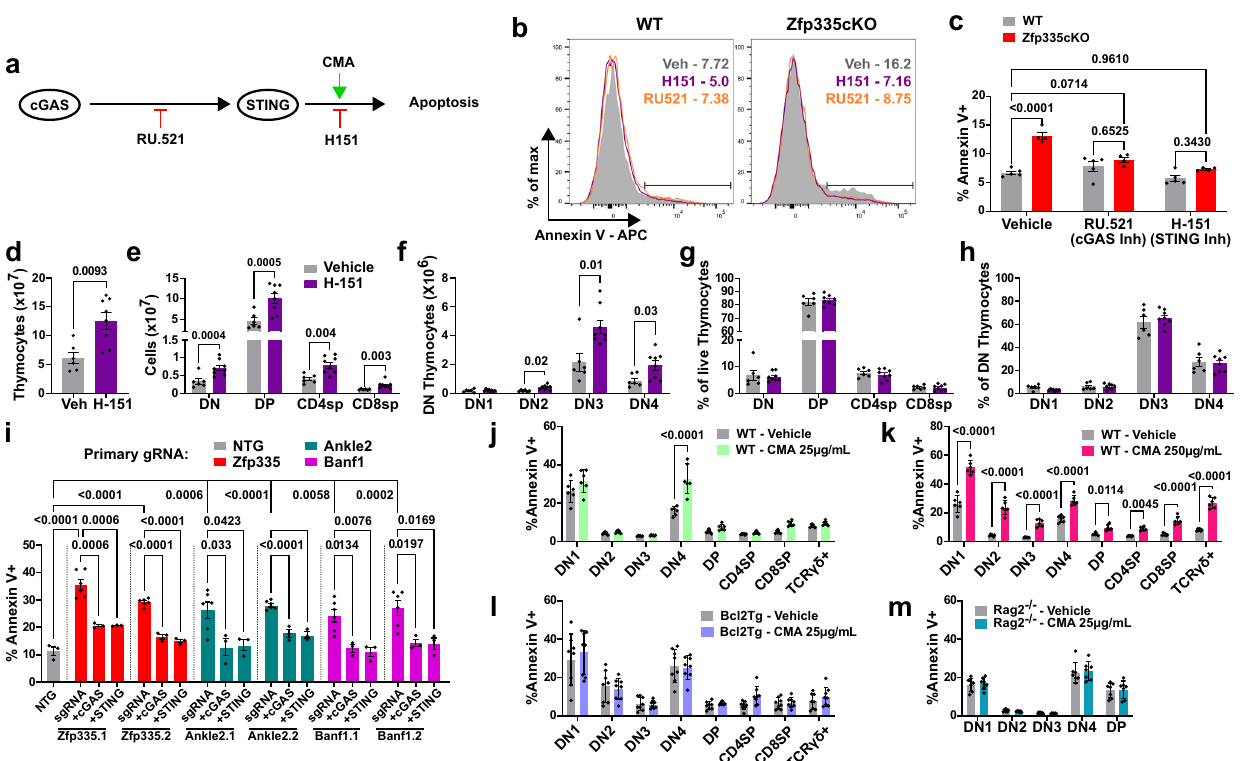
Fig. 7 | The Zfp335/Ankle2/Baf axis suppresses cGAS/STING-mediated apopto- sis of DN4 thymocytes. a Schematic diagram of inhibitors (RU.521 or H-151) or agonists (CMA) used to study cGAS/STING-dependent apoptosis of DN4 thymo- cytes.Representativehistograms( b )andquanti fi cation( c )ofAnnexinVbindingfor WT ( n =5 mice) or Zfp335cKO ( n =4 mice) DN4 thymoctes treated with cGAS (RU.521) or STING (H-151) inhibitors or vehicle control and cultured on OP9-DL1 stromal cells for 3 days. Total thymocyte ( d ), DN, DP, CD4SP, and CD8SP or DN1- DN4cellnumbers( e , f )orfrequencies( g , h )forZfp335cKOmicetreatedwithH-151 ( n =8 mice) or vehicle ( n =6 mice) in vivo for 7 days. i Quanti fi cation of Annexin V binding among DN4 cells from R26 LSL-Cas9 Tcrd CreERT2 thymocytes transduced with gRNA-expressing retroviruses and cultured for three days on OP9-DL1 cells with